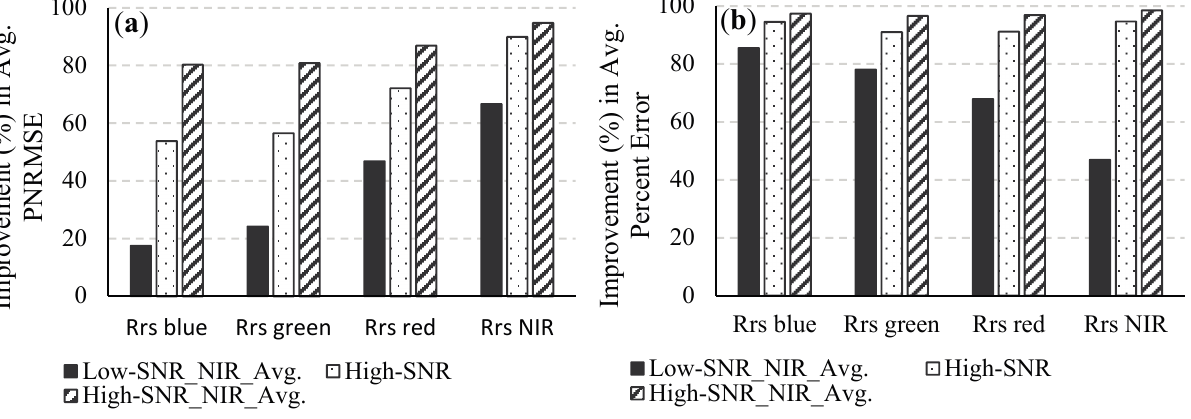
Figure 7. Improvements in ( a ) the average PNRMSE and ( b ) the average percent error of the retrieved R rs for the low-SNR system with spatial averaging in the NIR spectral bands, the high-SNR system, and the high-SNR system with spatial averaging in the NIR spectral bands over what was obtained for the low-SNR